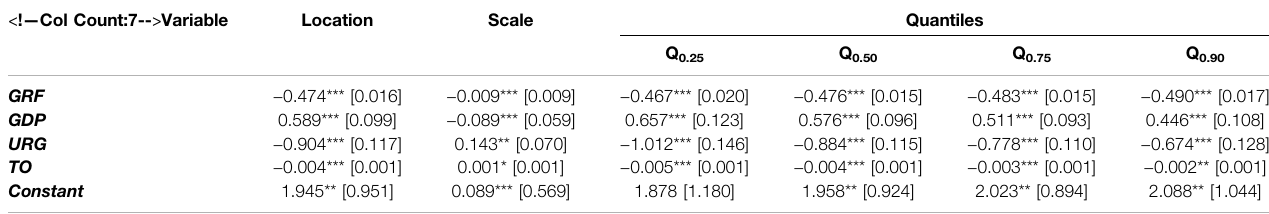
TABLE 7 | Estimates of quantile regression – MMQR (Model 1).